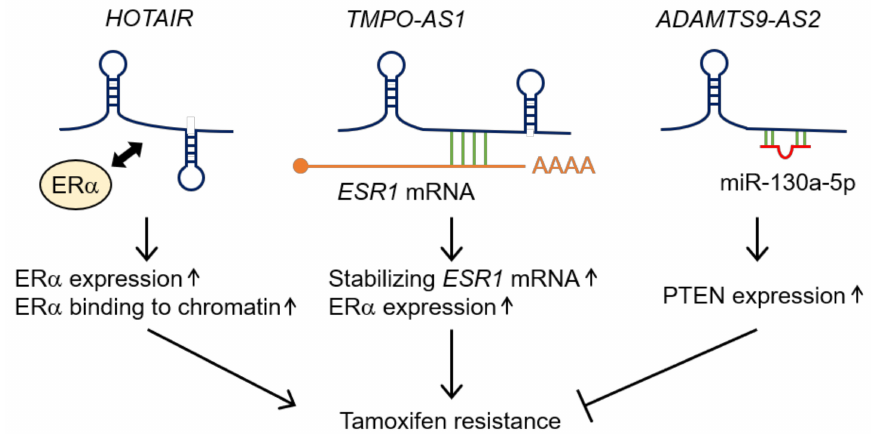
Figure 2. Schematic representation of the functions of HOTAIR , TMPO-AS1 , and ADAMTS9-AS2 in the tamoxifen resistance of breast cancer. HOTAIR enhances tamoxifen resistance by regulating the expression and activity of ER α . TMPO-AS1 binds and stabilizes ESR1 mRNA to enhance tamoxifen resistance. On the other hand, ADAMTS9-AS2 downregulates tamoxifen resistance by competing with miR-130a-5p to increase PTEN expression. HOTAIR : HOX transcript antisense RNA ; TMPO-AS1 : thymopoietin antisense transcript 1 ; ADAMTS9-AS 2: ADAM metallopeptidase with thrombospondin type 1 motif 9 ( ADAMTS9 ) antisense RNA 2 ; ER α : estrogen receptor α ; PTEN: phosphatase and tensin